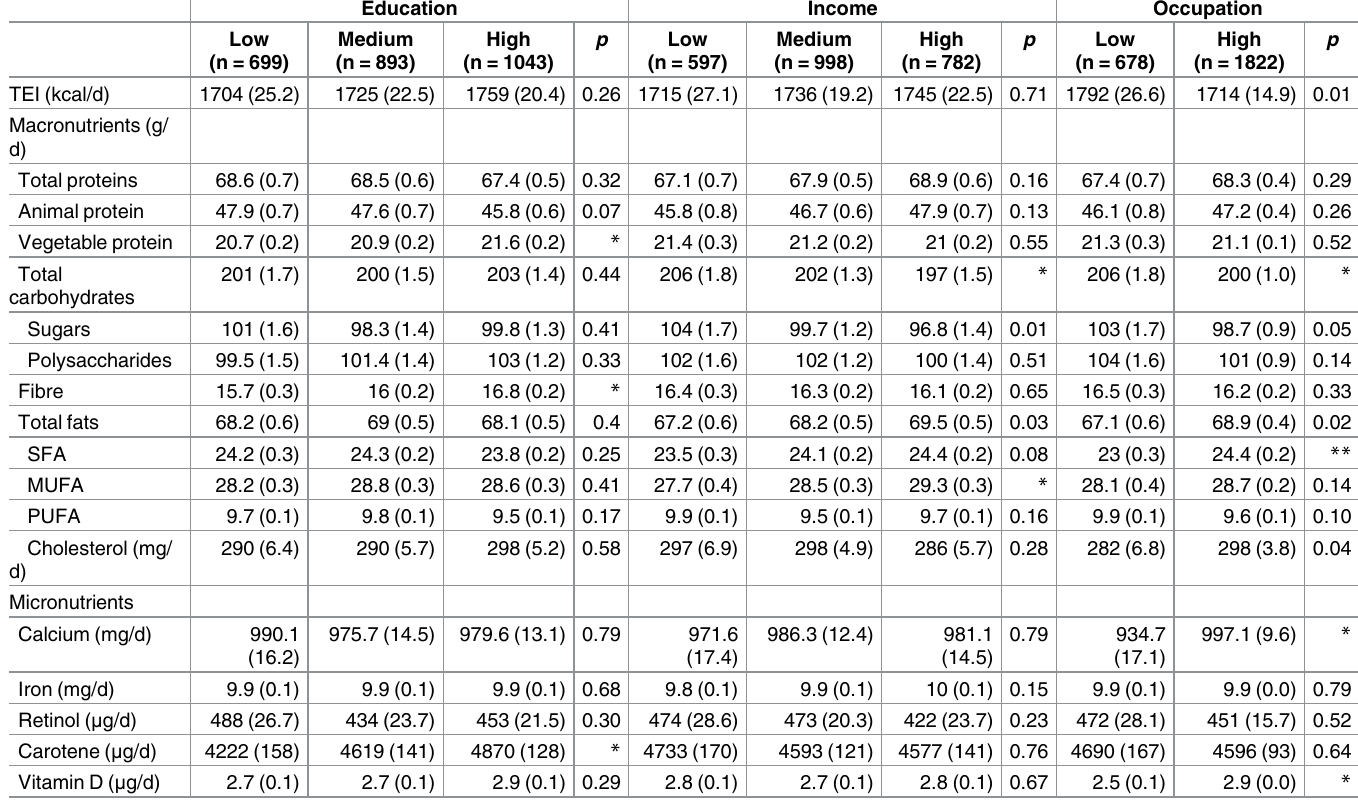
Table 5. Energy and nutrient intake (mean & SE) among women from “Bus Sante´” study, Geneva, Switzerland, years2005–2012,by socioeco- nomic status indicator, multivariable